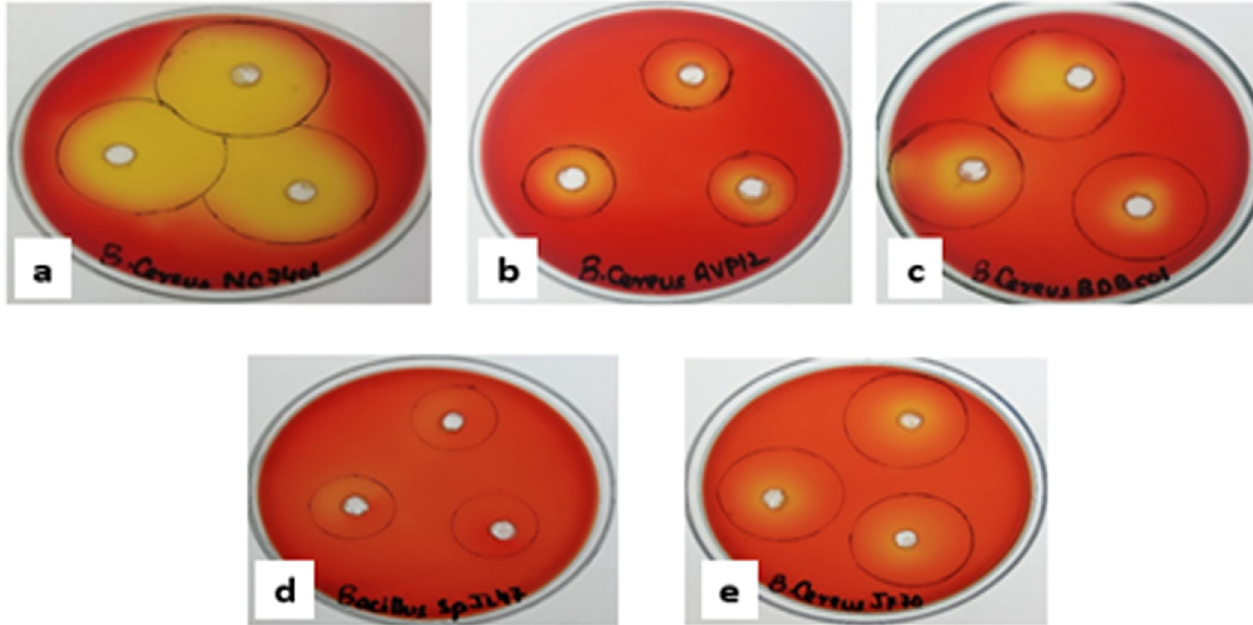
Fig 2. Screening of B . cereus strains for lipolytic activity with phenol red as pH indicator; a) B . cereus NC7401, b) B . cereus AVP12, c) B . cereus BDBCO1, d) B . specie JL47 and e) B . cereus